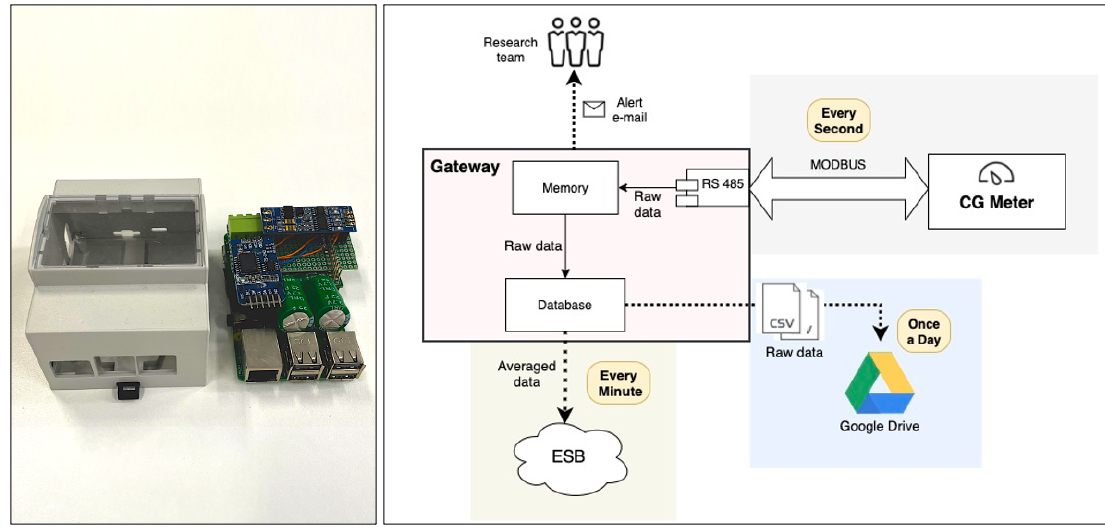
Figure 3. Left : Gateway used in the EnnerSpectrum System, the DIN box used for the installation, and the components that make up the GT; Right : Summary of the procedures carried out by the